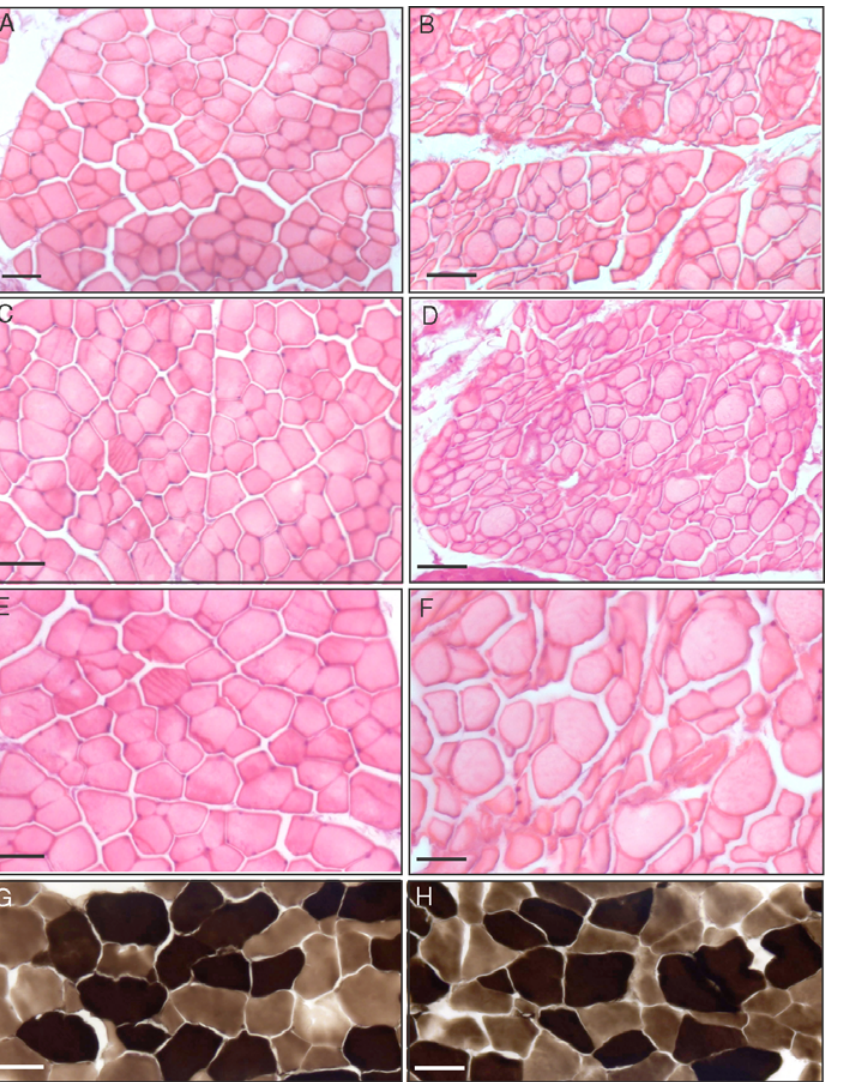
Figure 3. Histology and ATPase staining of muscle sections from gluteusmedius of BSE and BASE cattle and majorpsoas of BASE cattle. (A) Friesian cattle challenged with BSE and (B) BASE; (C, E) BSE- and (D, F) BASE-infected Alpine brown cattle. As opposed to the normal appearance of muscle tissue in BSE-infected cattle, groups of atrophic muscle fibers are seen in BASE-inoculated cattle. Hematoxylin and eosin staining (A–D scale bars 50 m m; E, F scale bars 20 m m). (G, H) Myosin ATPase staining of major psoas from BASE-infected cattle (code breed g, 995; h, 994) after preincubation at pH 4.6, shows that atrophic muscle fibers are both types I and II (scale bars 50 m m).